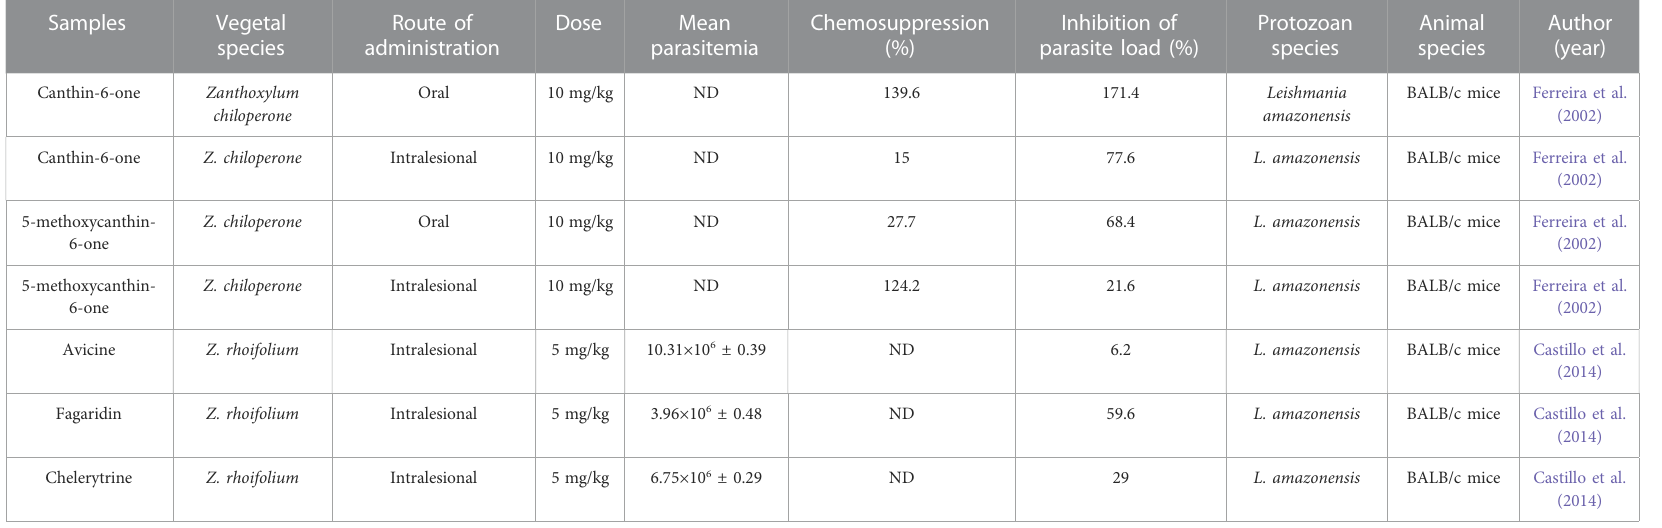
TABLE 6 In vivo antiparasitic activity against